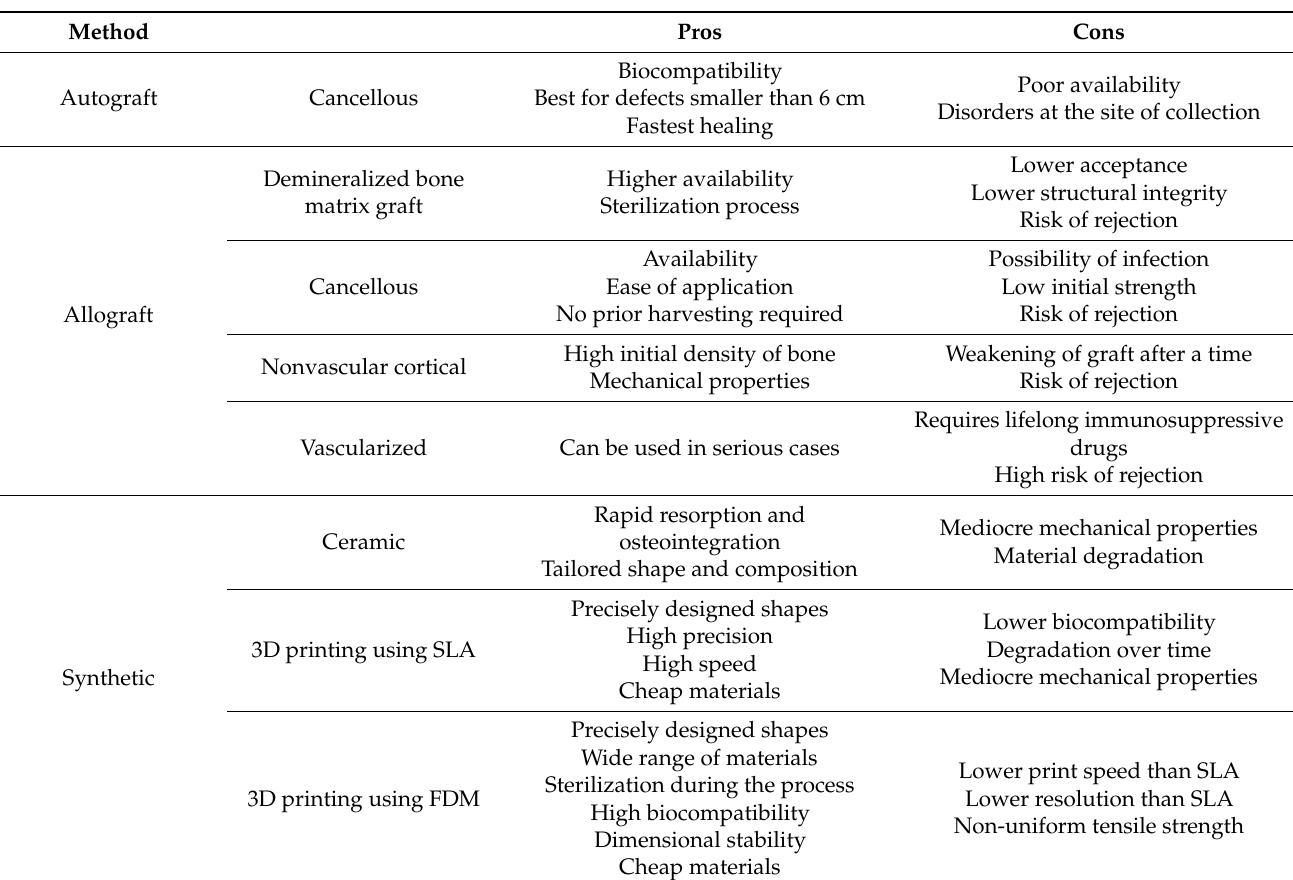
Table 3. Comparison between various grafting